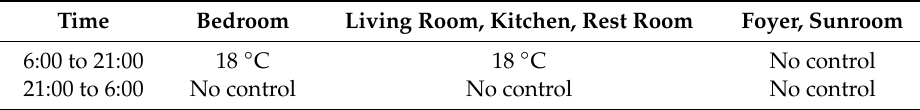
Table 7. Indoor thermal environment control of Demonstration House.